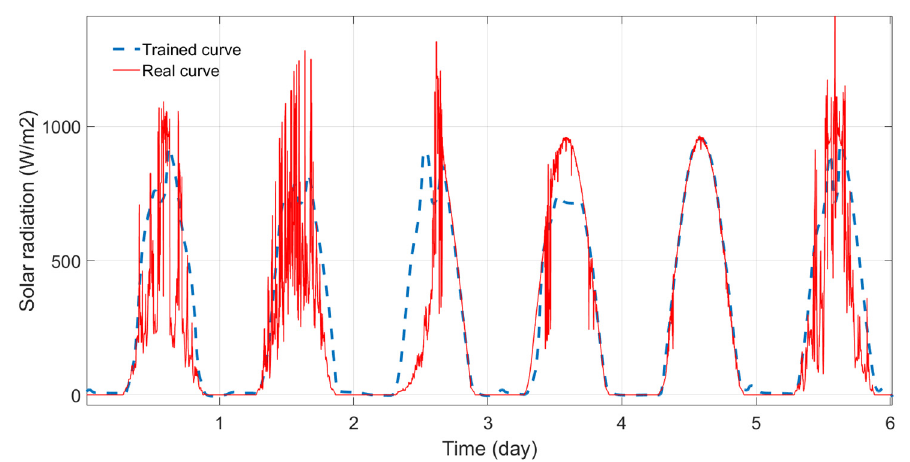
Figure 12. Training result in the case of the use of data containing nonconsecutive days.